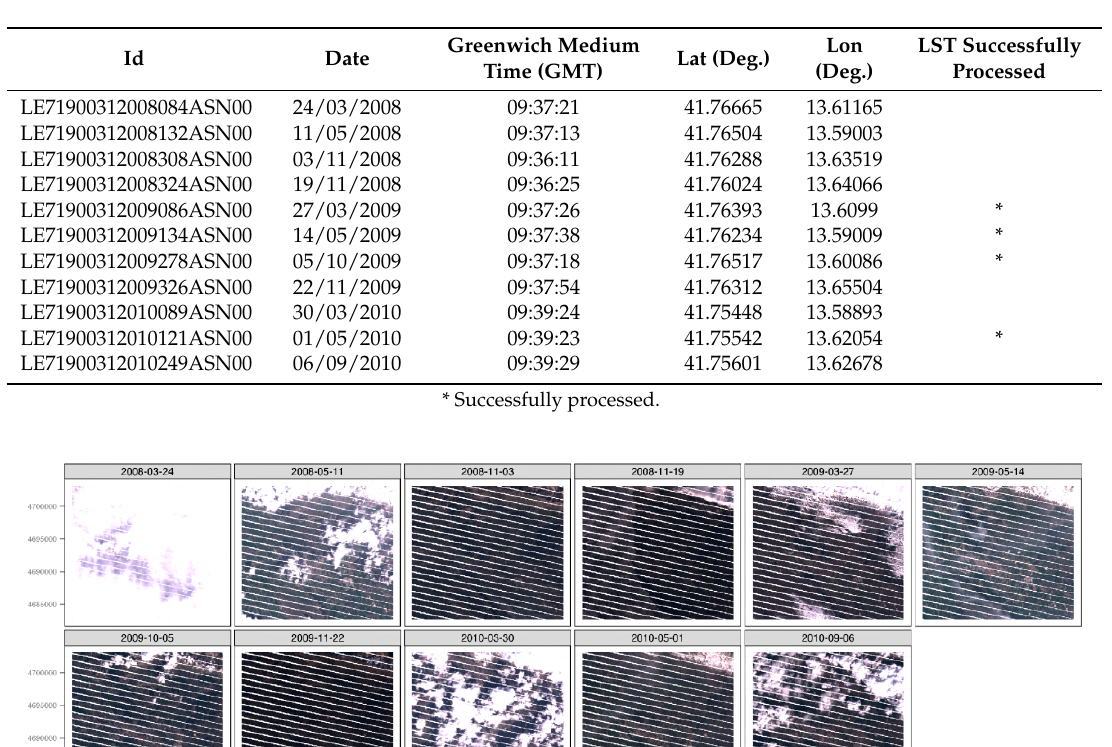
Table 1. Descriptive attributes of the Landsat Enhanced Thematic Mapper Plus (ETM+) images.